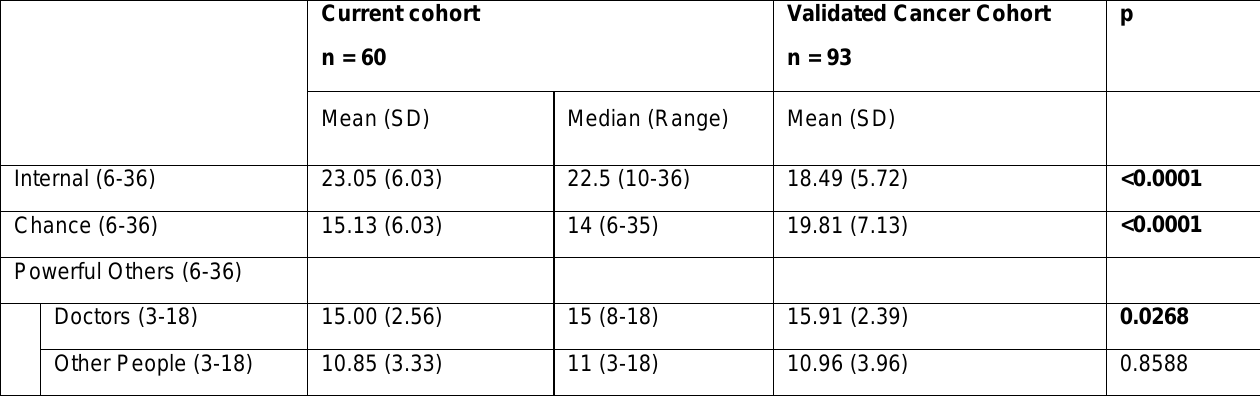
Table 4 Multidimensional Health Locus of Control – Form C Data Compared with Historical Cohort (Wallston et al.,